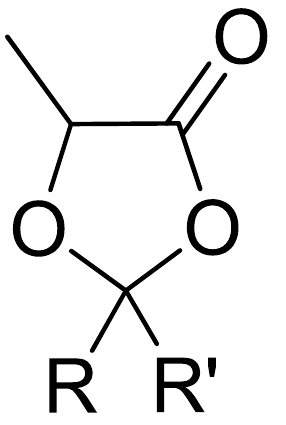
Figure 1. Lewis structure of 2,2-R,R'-5-methyl-1,3-dioxolan-4-one.